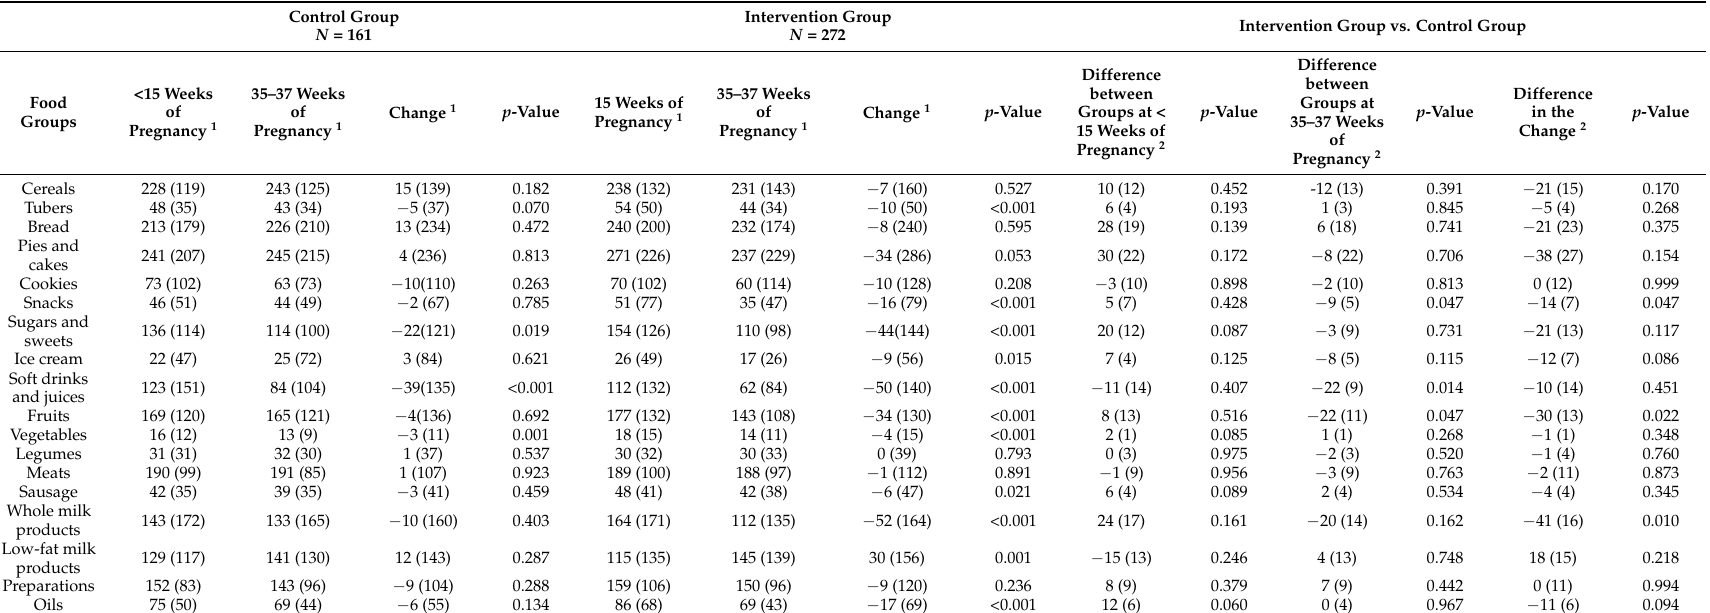
Table 4. Energy consumption (kcal/day) by food